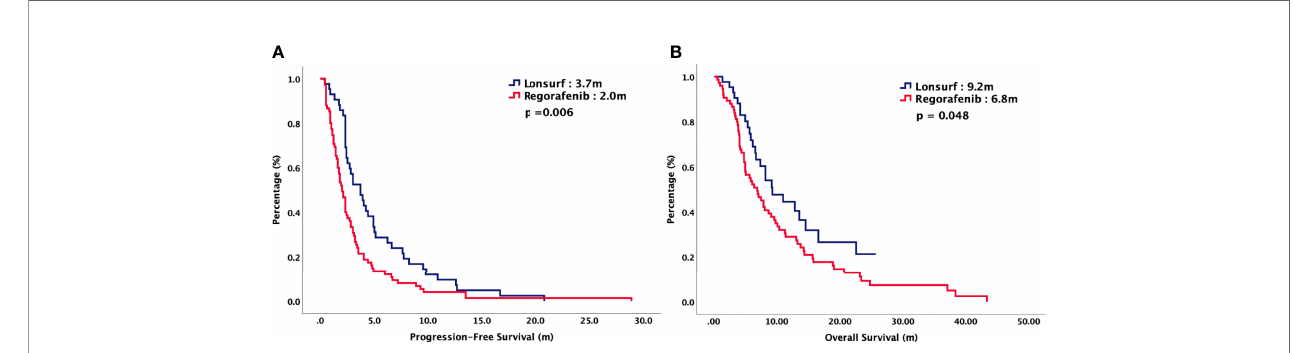
FIGURE 1 | (A) Progression-free survival and (B) overall survival of 125 patients with chemorefractory mCRC, strati fi ed by